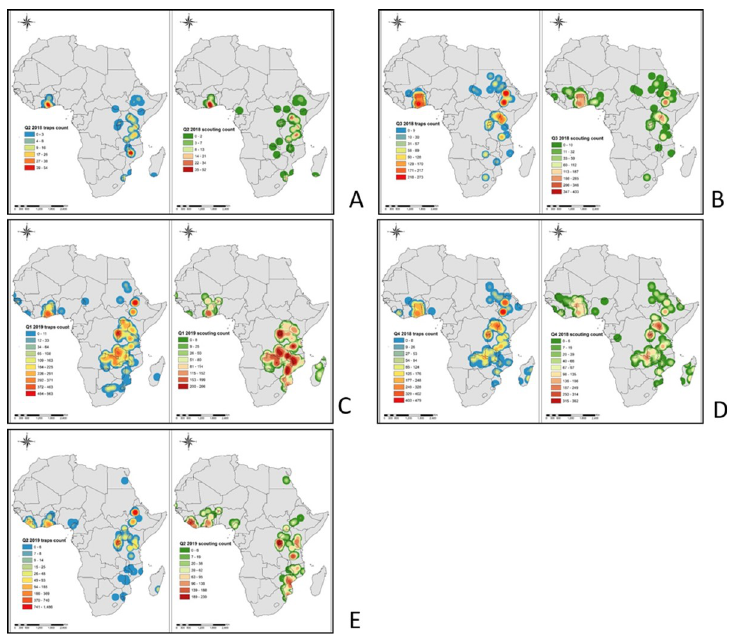
Fig 9. Evolution of fall armyworm infestation according to the time for scouting and trap counts. A) The second quarter of 2018, i.e. April, May and June; B) The third quarter of 2018, i.e. July, August and September; C) The fourth quarter of 2018, i.e. October, November and December; D) The first quarter of 2019, i.e. January, February and March; E) The second quarter of 2019, i.e. April, May and